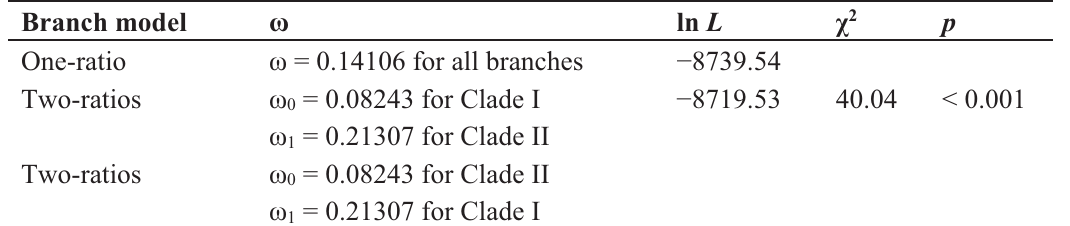
Table 2. Summary statistics of clades for detecting selection using branch models in